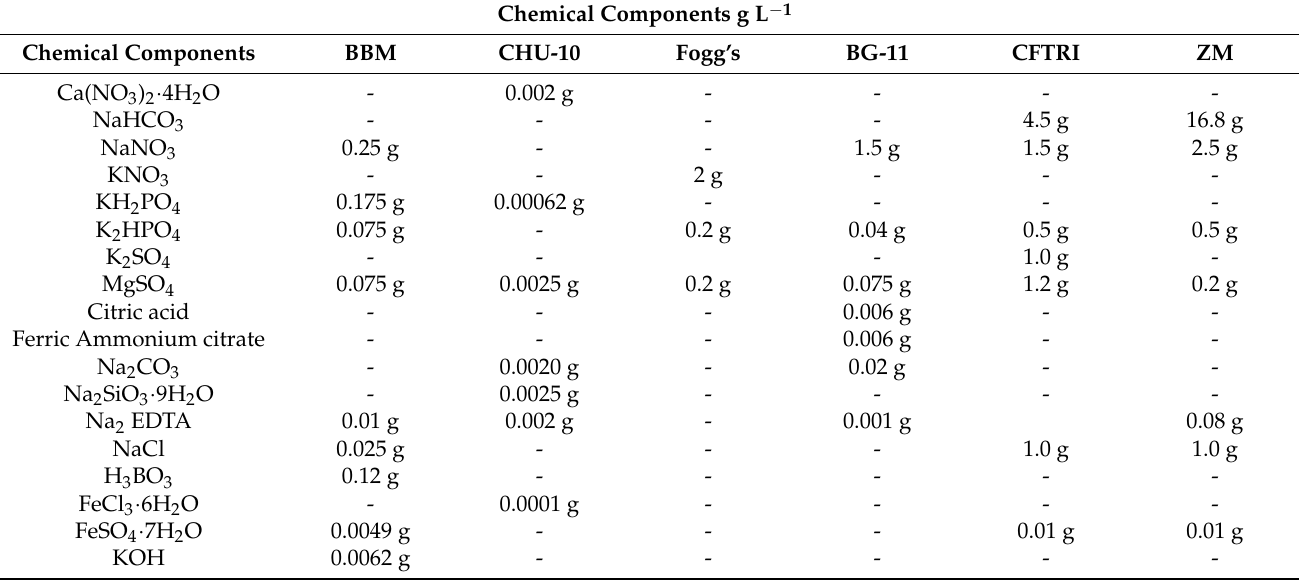
Table 1. Chemical composition of different autotrophic growth